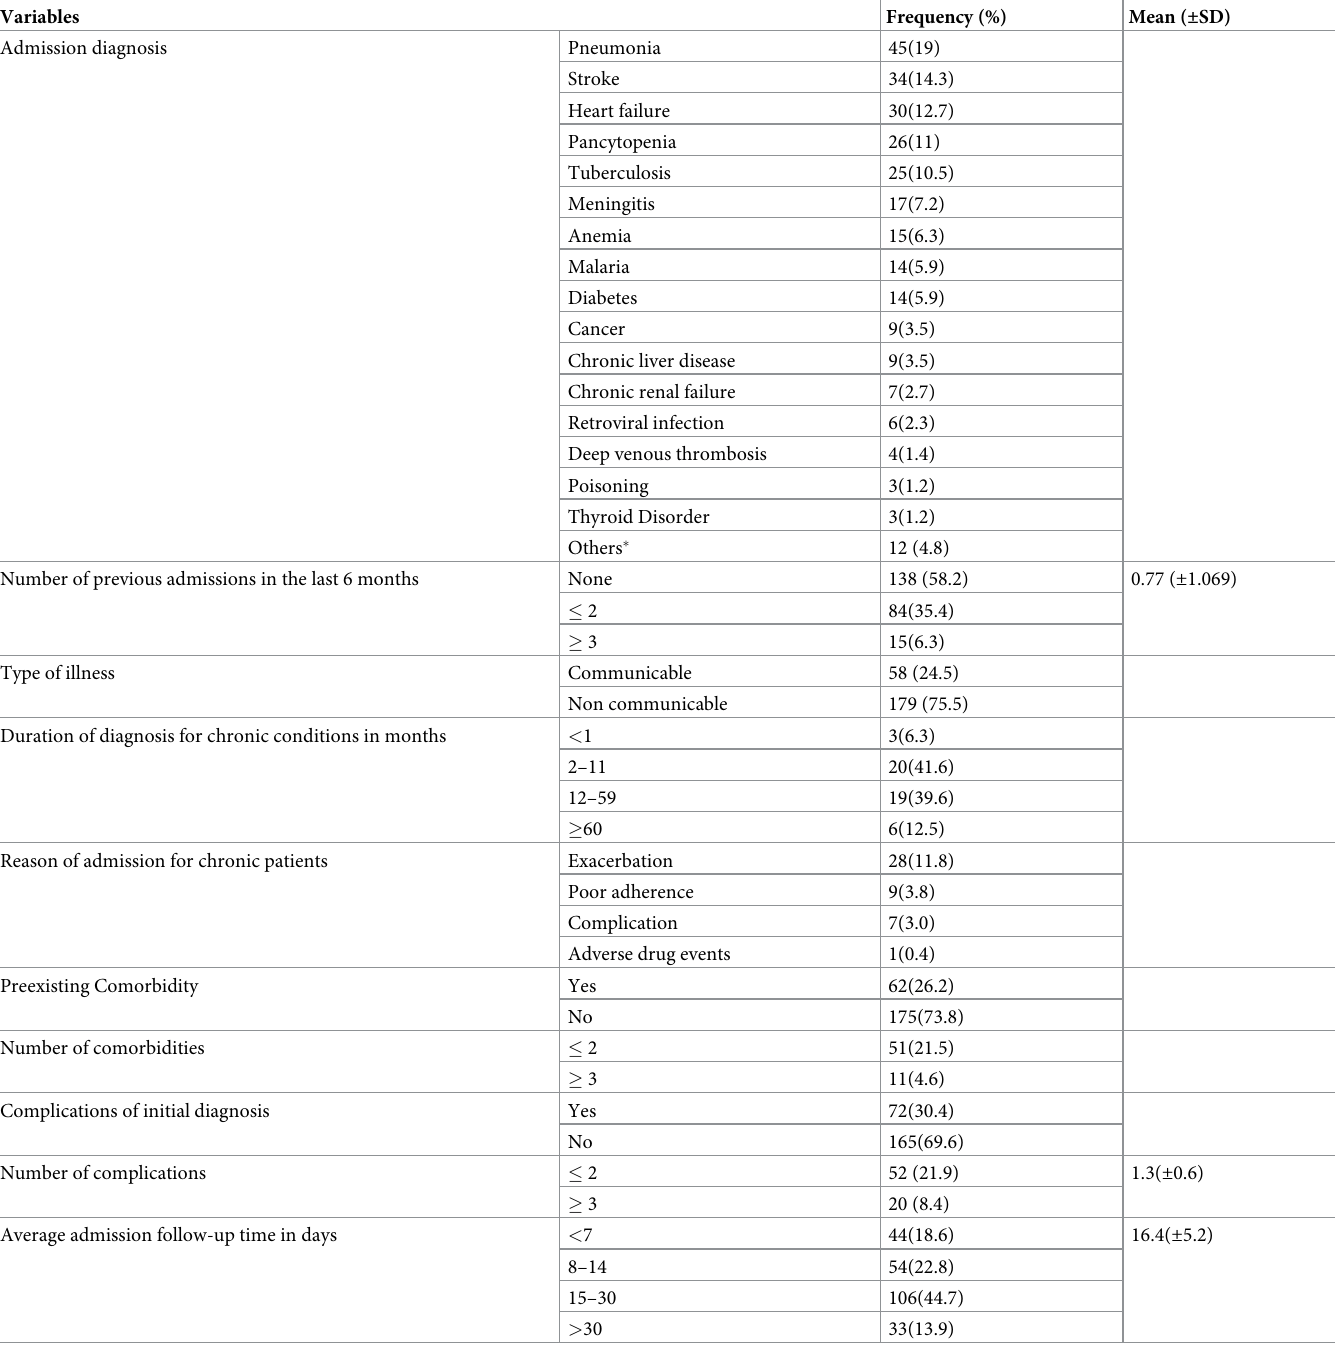
Table 2. Clinical characteristics of hospitalized patients in the UoGCSH medical ward from May 28 to July 26, 2022 (N =